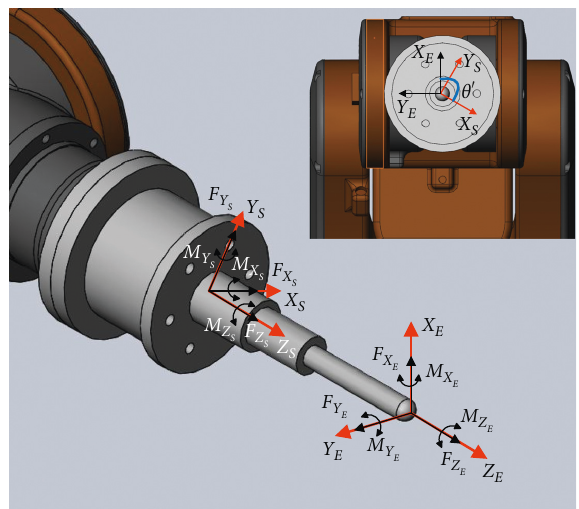
Figure 4: End coordinate system and sensor coordinate system.